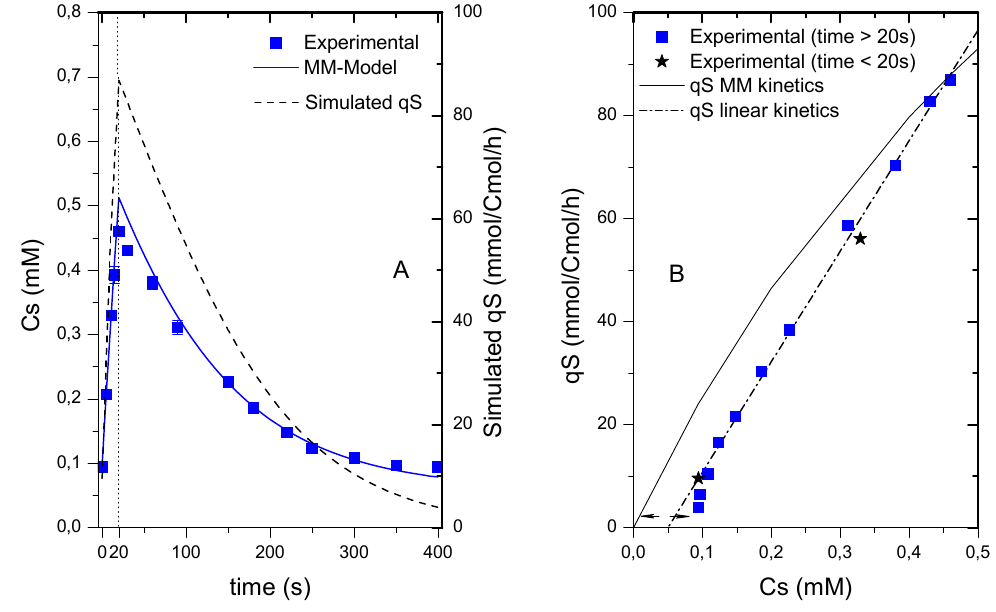
Figure 2. Dynamics of the residual glucose concentration and uptake rate during the cycle. ( A ) Measured extracellular glucose concentration (Cs, closed squares) and Simulated extracellular glucose concentration (solid line) using a MM model (Km = 1mM, q = 279 mmolCmol − 1 h − 1 ); Dynamics of the specific uptake rate (q ) in time (dashed line); S,max S ( B ) Comparison of the experimental q (from interpolation) as a function of C S S (extracellular glucose concentration) to a hyperbolic function (solid line) and a linear function (dot-dashed line). The vertical dotted line represents the end of the feeding